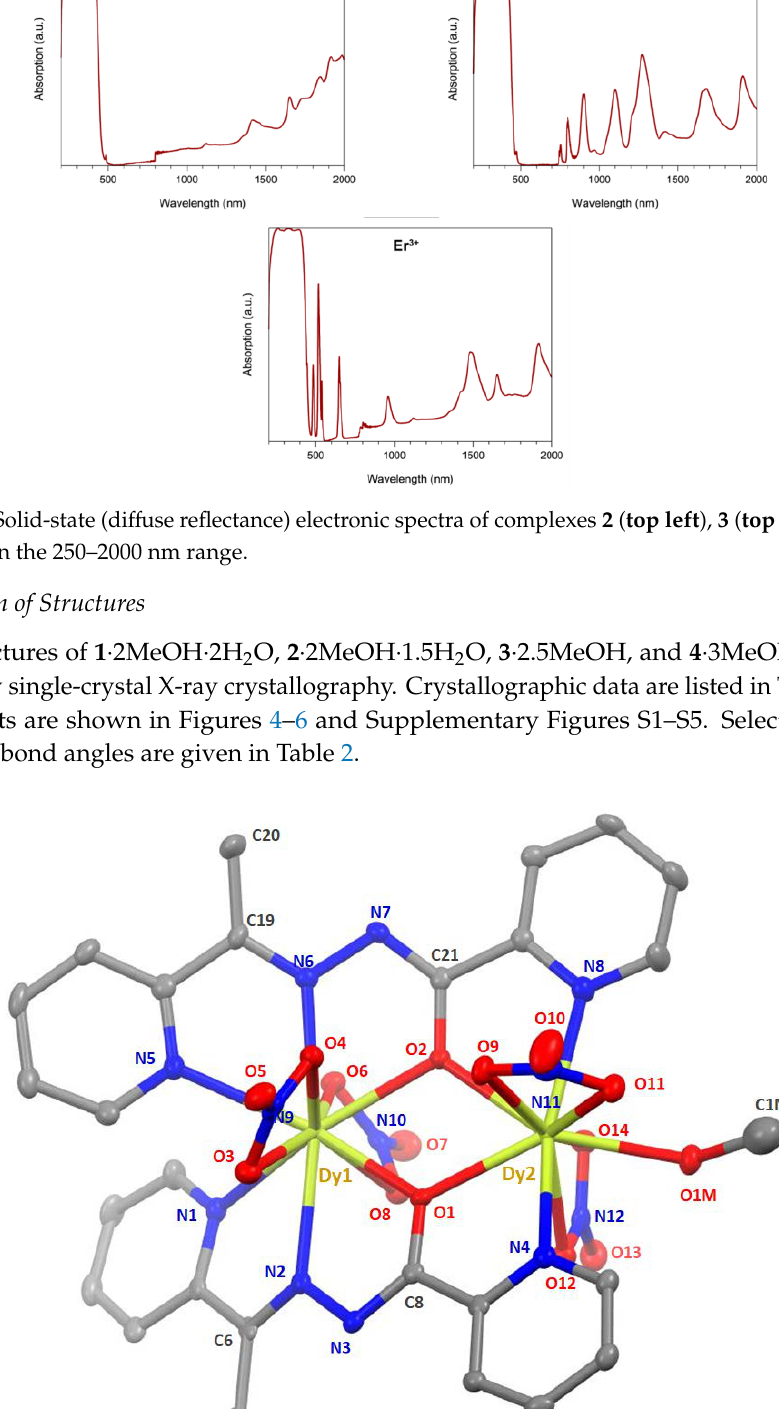
Figure 5. Molecular structure of [Er 2 (NO 3 ) 4 (L) 2 (H 2 O)] as found in 4 ∙3MeOH∙0.5H 2 O. Thermal ellipsoids are depicted at 50% probability level. Hydrogen atoms are omitted for clarity.